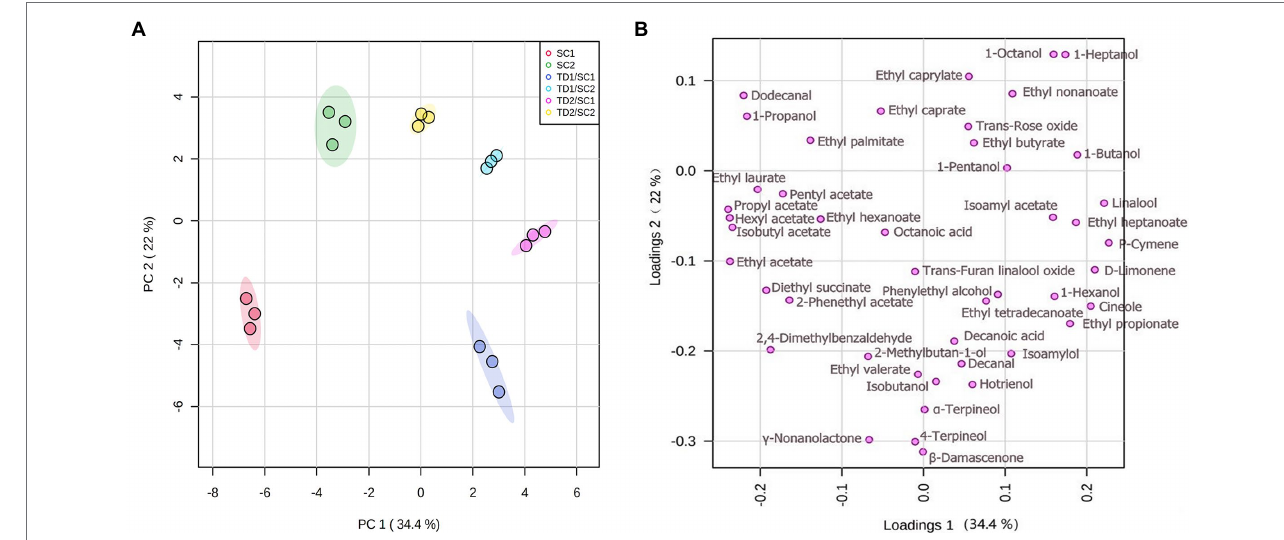
FIGURE 3 | Principal component analysis (PCA) bi-plots of major aroma compounds in pure and mixed fermented icewines. There are score plot (A) and loading plot (B) . TD1/SC1, TD2/SC1, TD1/SC2, TD2/SC2: sequential inoculation with T. delbrueckii (TD1, TD2) followed by S. cerevisiae (SC1, SC2) after 48 h; SC1 and SC2: single inoculation of S. cerevisiae SC1 and SC2,